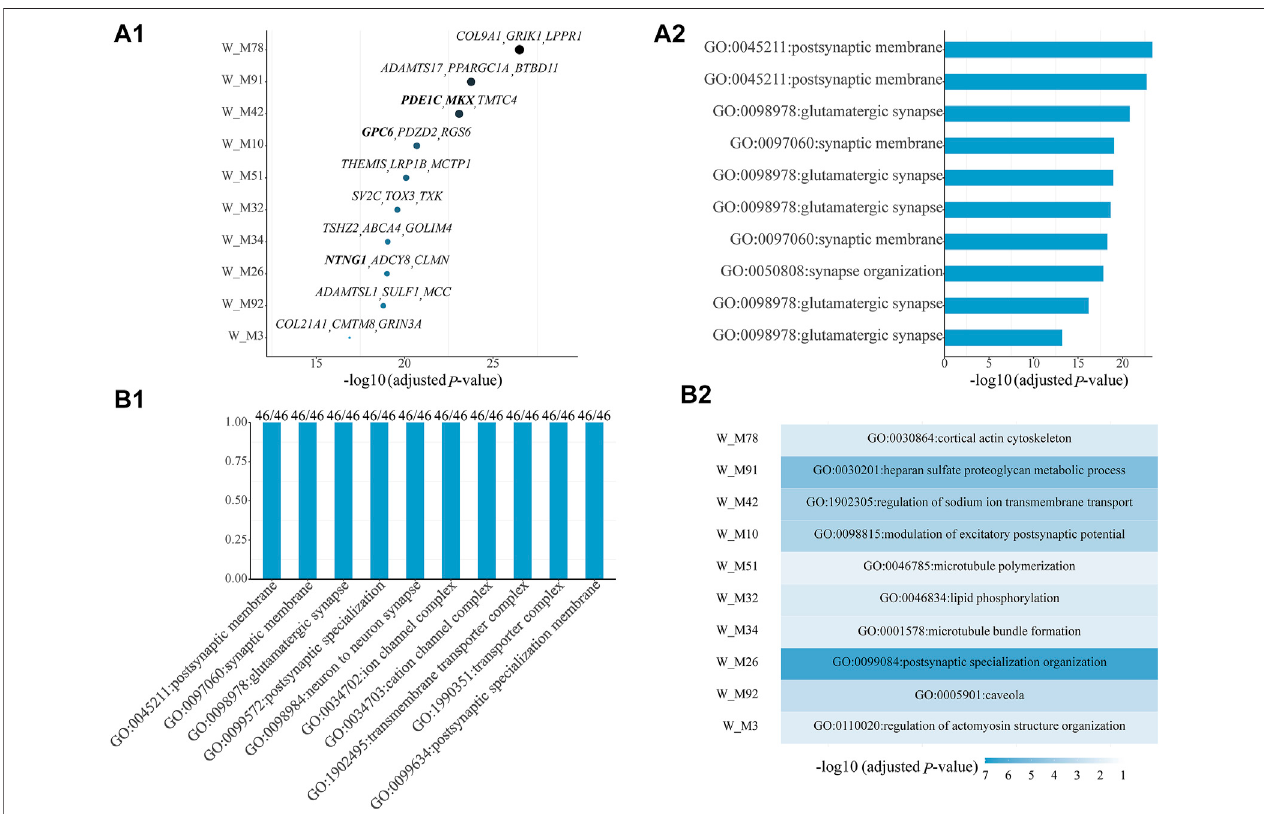
FIGURE 1 | Top ten shared ASD-associated gene modules along with (A1) their Bonferroni-adjusted p -values, top three z-score genes, and (A2) top one signi fi cant GO term. (B1) Top ten common enriched GO terms among all shared ASD-associated gene modules along with the frequency of occurrence and the total number of gene modules. (B2) Module-speci fi c top one GO term of the top ten shared ASD-associated modules. The SFARI ASD genes are bold. The Bonferroni- adjusted p-values were derived from the hypergeometric tests using module genes and ASD